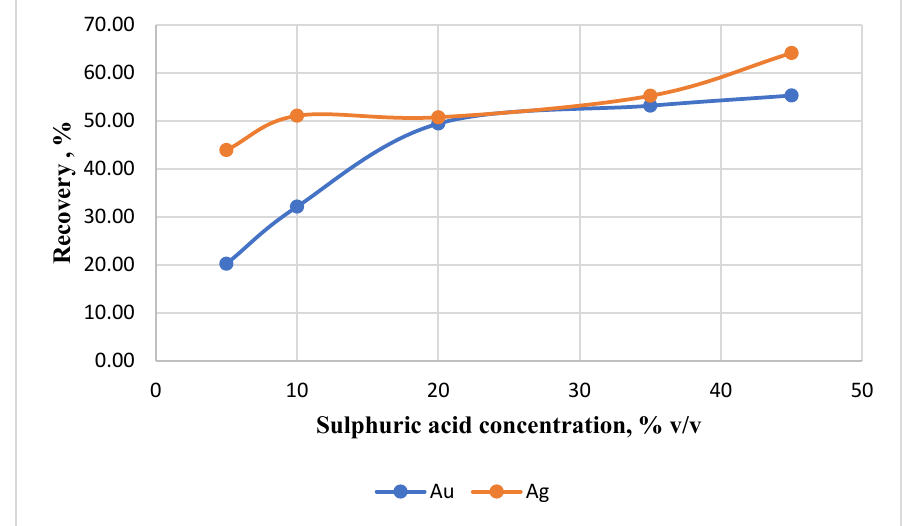
Figure 9. Gold recovery as a function of pretreatment acid concentration.